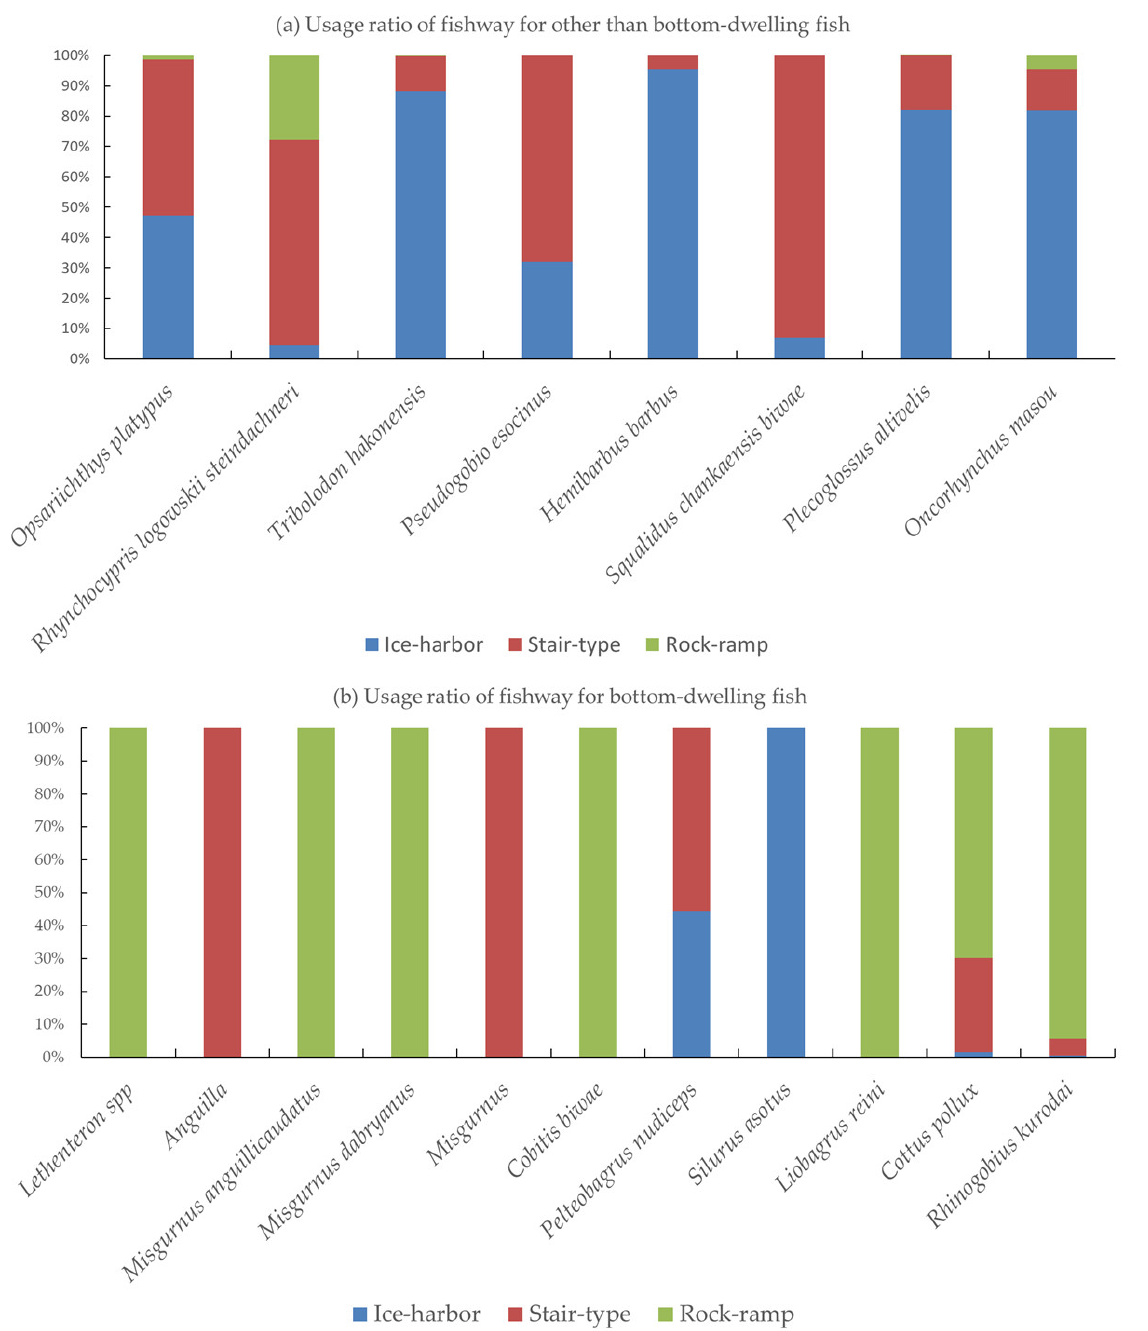
Figure 4. Usage ratio of the fishway for each caught fish over four years (2012–2015): ( a ) usage ratio for other than bottom-dwelling fish; ( b ) usage ratio for bottom-dwelling fish.